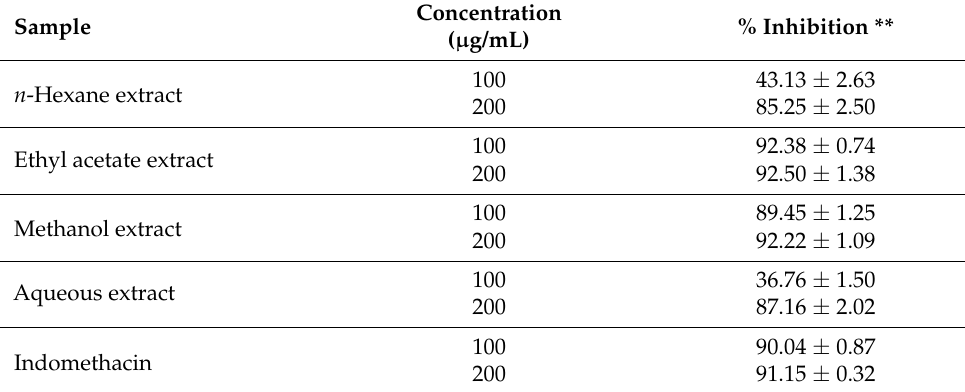
Table 3. In vitro inhibition of protein denaturation by Cassia timoriensis